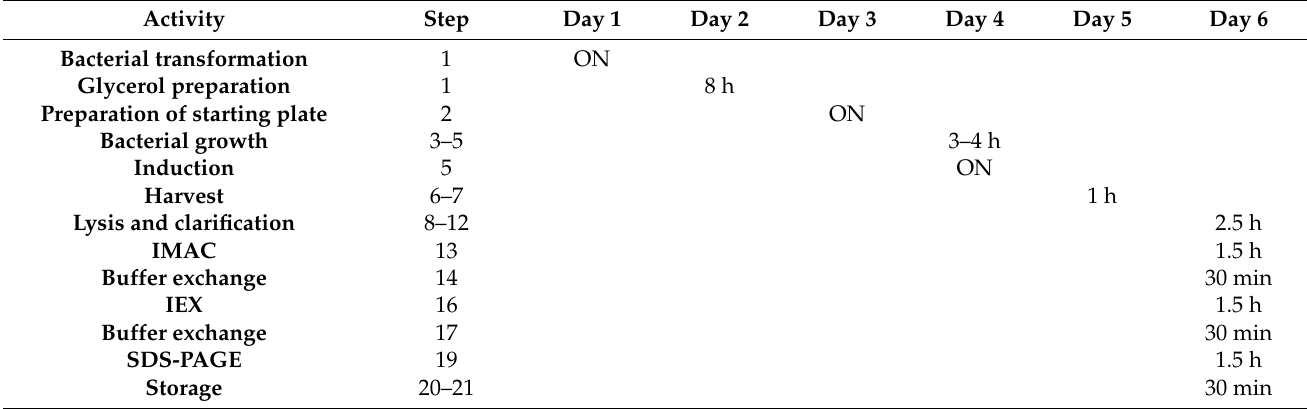
Figure 1. ( A ) PMJ922 map from Addgene. ( B ) 6xHis − MBP − Sp Cas9 NLS − GFP transcriptional unit. 6xHis − MBP can be removed by cleavage with TEV protease. Physicochemical properties for chimeric proteins Sp Cas9 − GFP − MBP and Sp Cas9 − GFP are indicated to the right. Table 2. Experimental